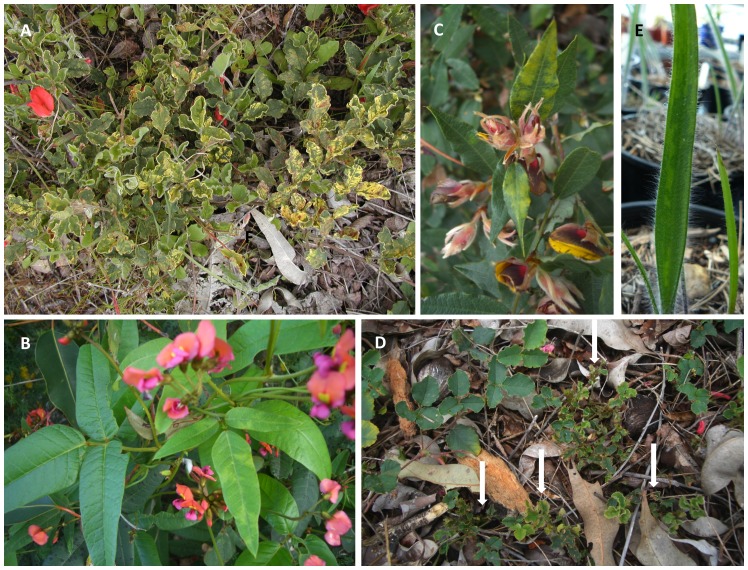
Native plants growing in the South West Australian Floristic Region showing obvious virus symptoms.For locations of site names see Fig. 1. A, Severe chlorotic mottle and leaf deformation caused by infection with an introduced generalist virus (Bean yellow mosaic virus, BYMV) in plants of Kennedia prostrata growing near Badgingarra; B, Mild mosaic caused by infection with an unidentified virus in young leaflets (right) of K. coccinea plants growing near Wooroloo; C, Bright yellow leaf mottle caused by infection with an unidentified virus in young leaves of a Bossiaea sp. plant growing at The Lakes; D, Chlorotic leaf mottle, leaf deformation and severe plant stunting (plants with arrows) caused by infection with an unidentified virus in plants of K. prostrata growing near Wooroloo compared with vigorously growing healthy K. prostrata plants (top left and right); E, Leaf mosaic caused by infection with BYMV in leaf of Caladenia paludosa growing in an orchid collection at Kings Park.